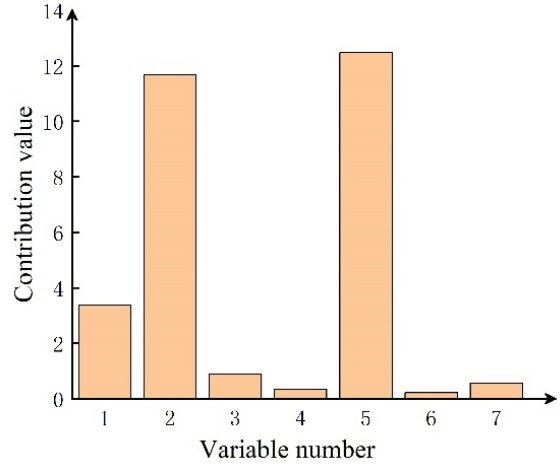
Figure 18. Nonlinear contribution plot of sample 1.